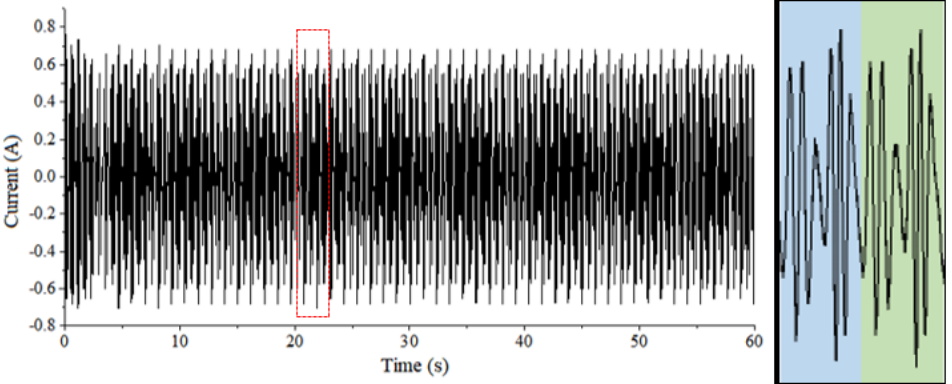
Figure 14. Current diagram (including the zoom-up of the enclosed region between 20.0 s and 22.4 s) under traveling waves of T / T p = 1.0, h = 0.6 m.